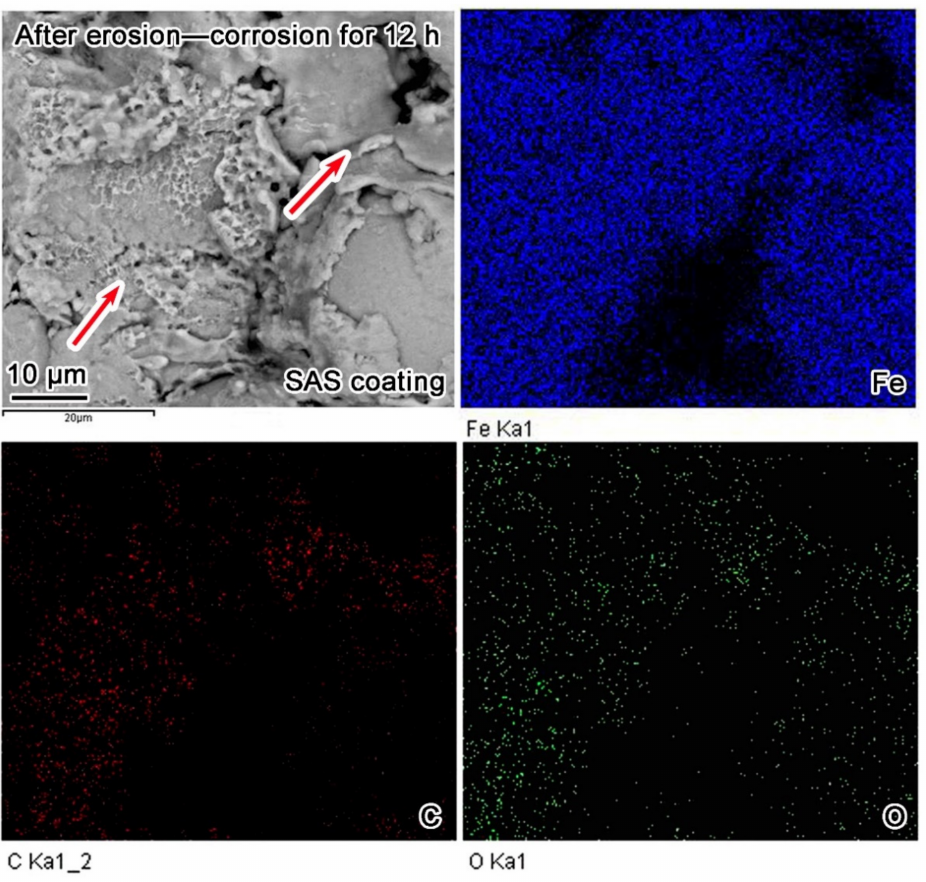
Figure 12. SEM micrograph and EDS elemental mapping of SAS coating surface after erosion– corrosion tests for 12 h by 3.5 wt.% NaCl solution containing 2 wt.%